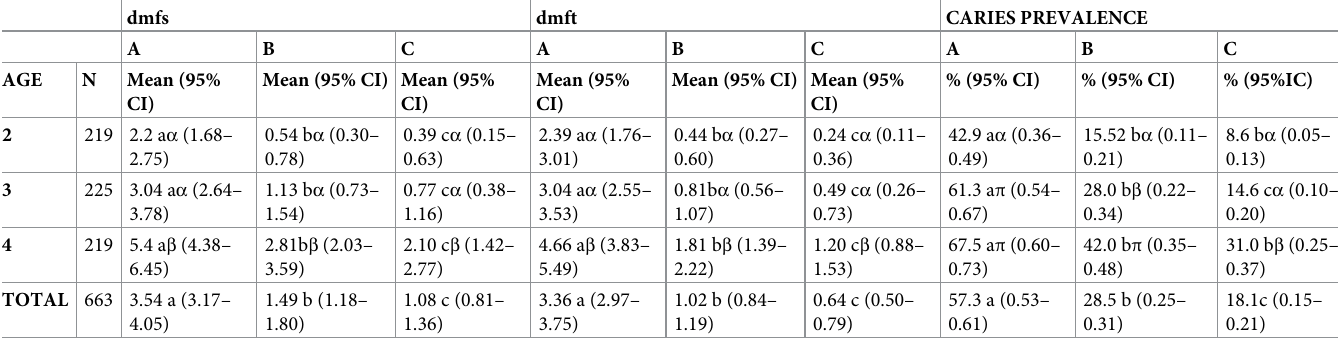
Table 4. dmfs, dmft and caries prevalence by age range. dmfs dmft CARIES